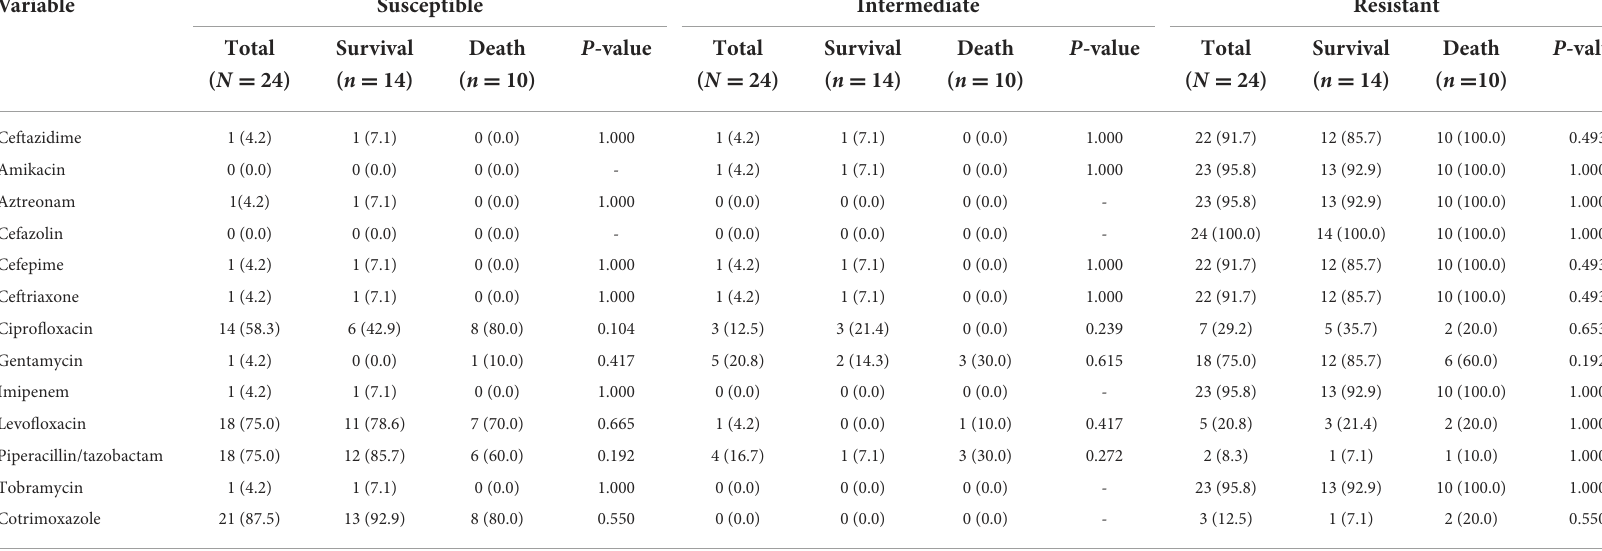
TABLE 4 The corrected “TABLE 4 In vitro of drug susceptibility results of patients infected with E. meningoseptica ( N = 24).” Variable Susceptible Intermediate